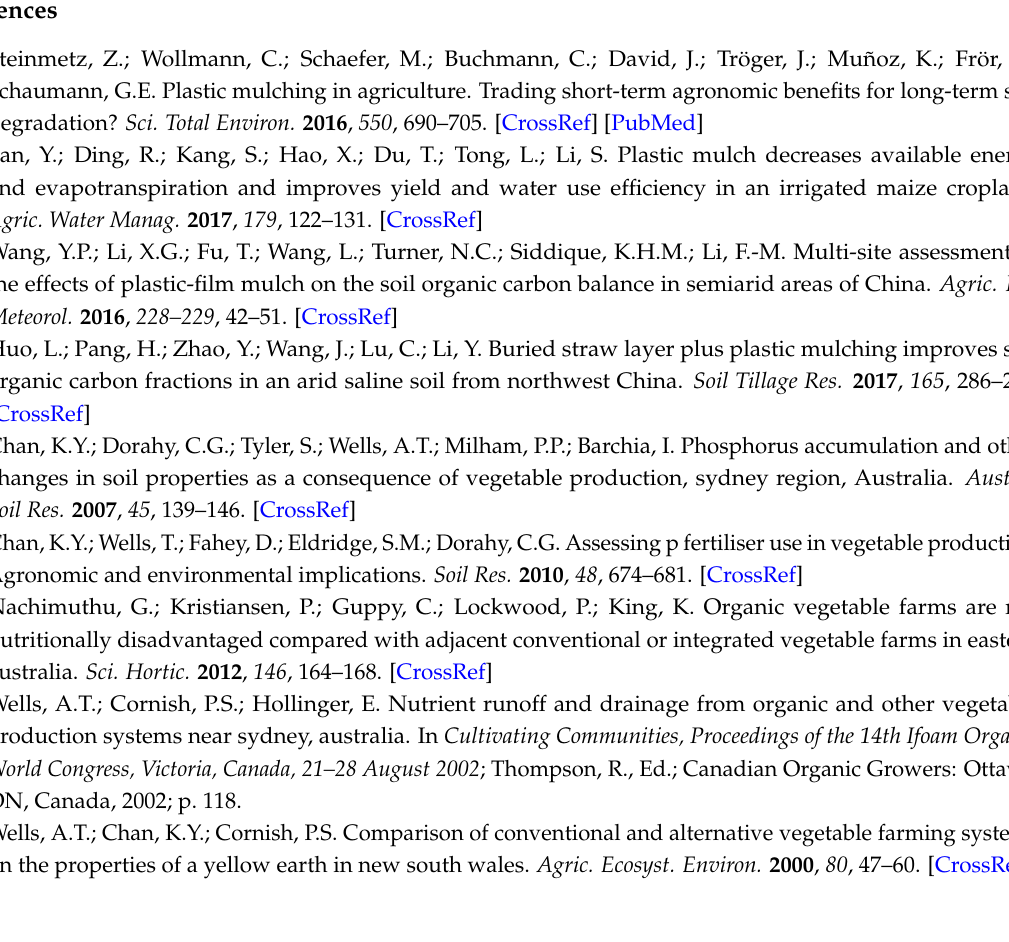
Figure S1: Soil temperature recorded at 5 cm depth during the winter zucchini crop, showing the difference between plastic mulch and trash systems; Figure S2: Soil temperature recorded at 5 cm depth from December 2010 until late January 2011 during the spring/summer capsicum crop, showing the difference between plastic mulch and trash